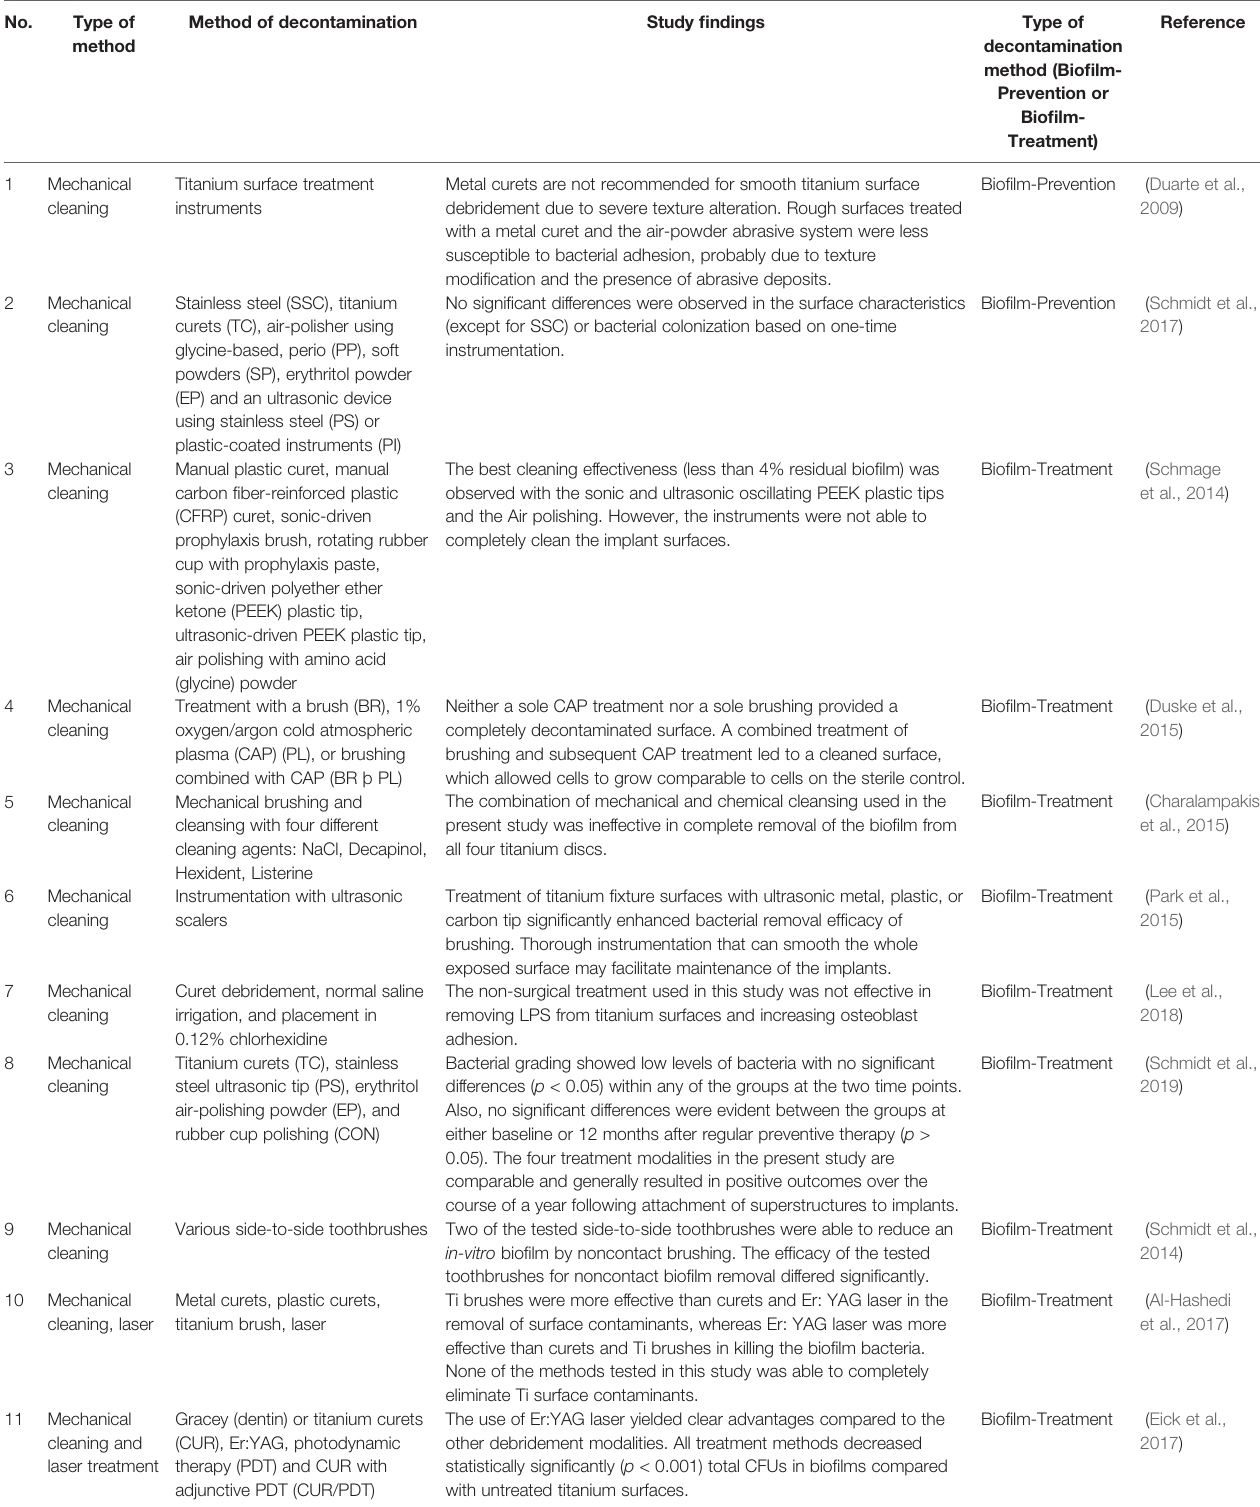
TABLE 1 | Decontamination methods using specialized instruments and the fi ndings of the respective studies.